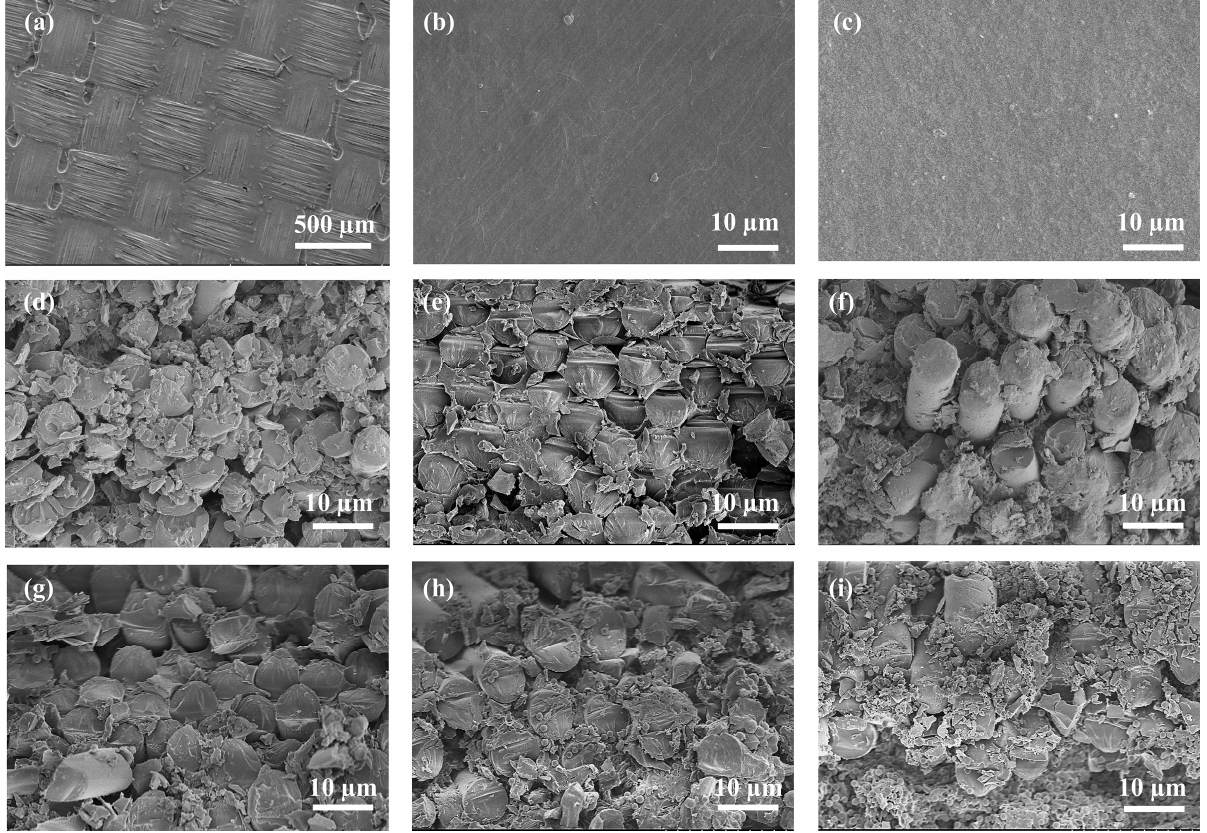
Figure 3. Surface morphology of different composites: ( a ) PB/SEBS/0 g COC (C0); ( b ) PB/SEBS/15 g COC (C15); ( c ) PB/SEBS/20 g COC (C20); cross ‐ sectional morphology of different composites: ( d ) PB/SEBS/5 g COC (C5); ( e ) PB/SEBS/15 g COC (C15); ( f ) PB/SEBS/20 g COC (C20); ( g ) PB/SEBS/COC/10 wt% SiO 2 (S1); ( h )PB/SEBS/COC/30 wt% SiO 2 (S3); ( i )PB/SEBS/COC/10 wt% SiO 2 (S5).